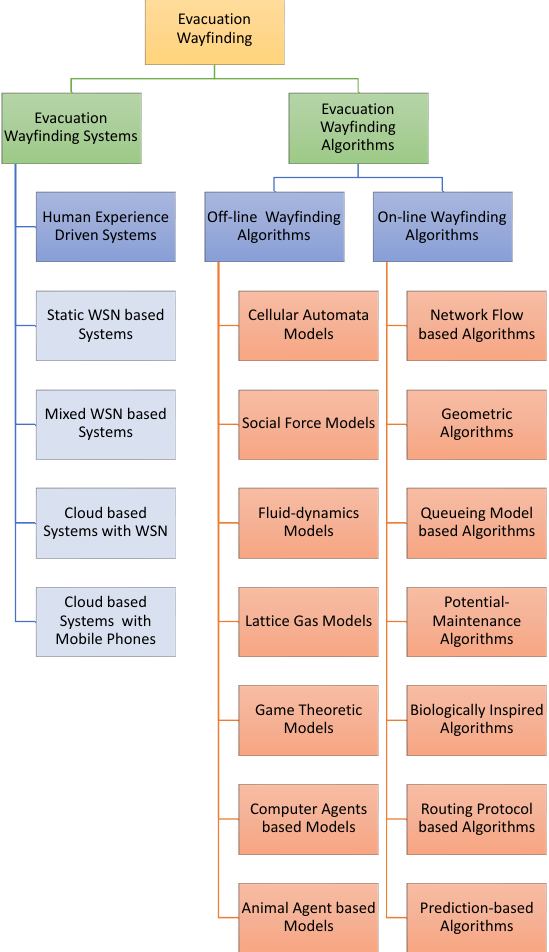
Figure 1. A tree diagram explaining the structure of the paper. We summarise the classical research and ideas of evacuation wayfinding from both system structure and algorithm design